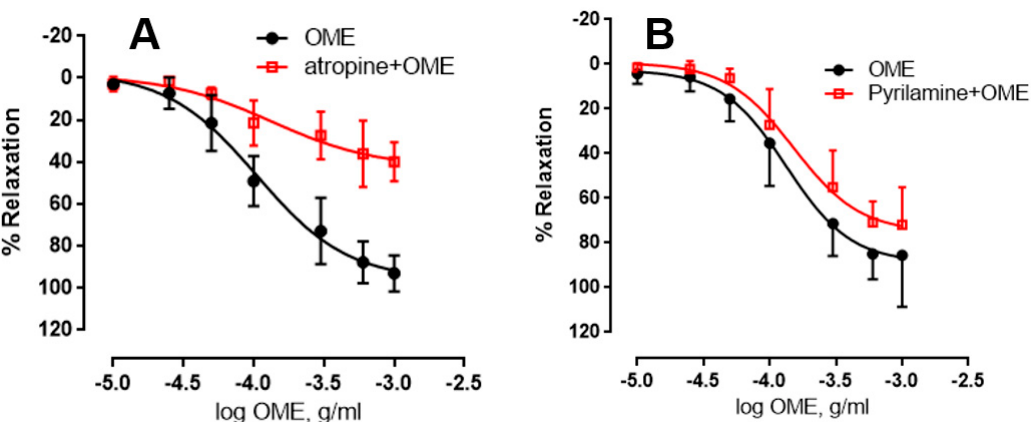
Figure 8. Involvement of histaminic or muscarinic receptors in OME-induced relaxation. Rings with intact endothelium were incubated with cumulative doses of OME in the absence (OME; black) or presence of ( A ) 10 µ M of atropine (natural alkaloid with antagonistic properties at muscarinic acetylcholine receptors; atropine + OME; red) or ( B ) 10 µ M of pyrilamine (blocker of H 1 histamine receptors; pyrilamine + OME; red). Data showed represent mean ± SEM ( n = 6 or 5 for atropine or pyrilamine-treated rings, respectively). p < 0.05 for OME alone vs. either atropine + OME; p > 0.05 for OME alone vs. either pyrilamine + OME.